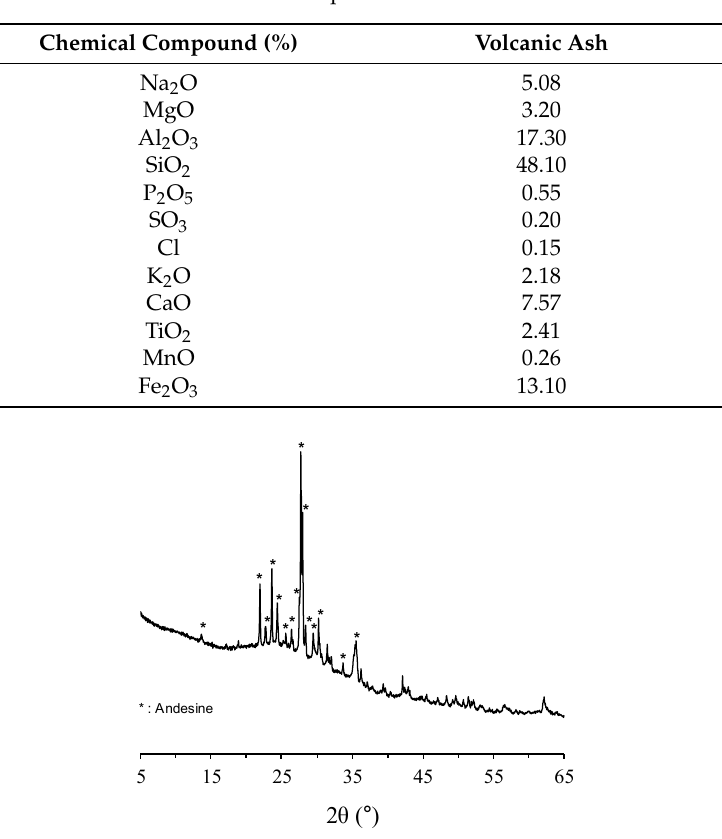
Table 2. Chemical composition of the volcanic ash.